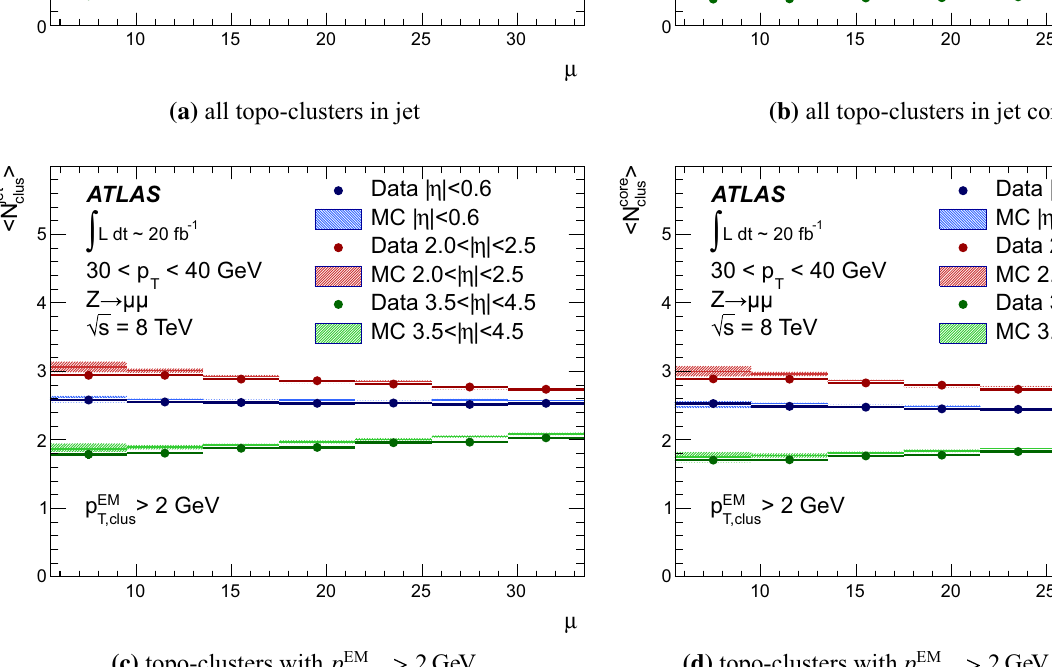
(cid:8) in anti- k is shown in b . Selecting topo-clusters by p EM t jets clus < 40GeV as and in the core of the jet yields the μ dependencies shown in c and d . T , jet The shaded bands shown for the results obtained from MC simulations (cid:8) indicate statistical clus